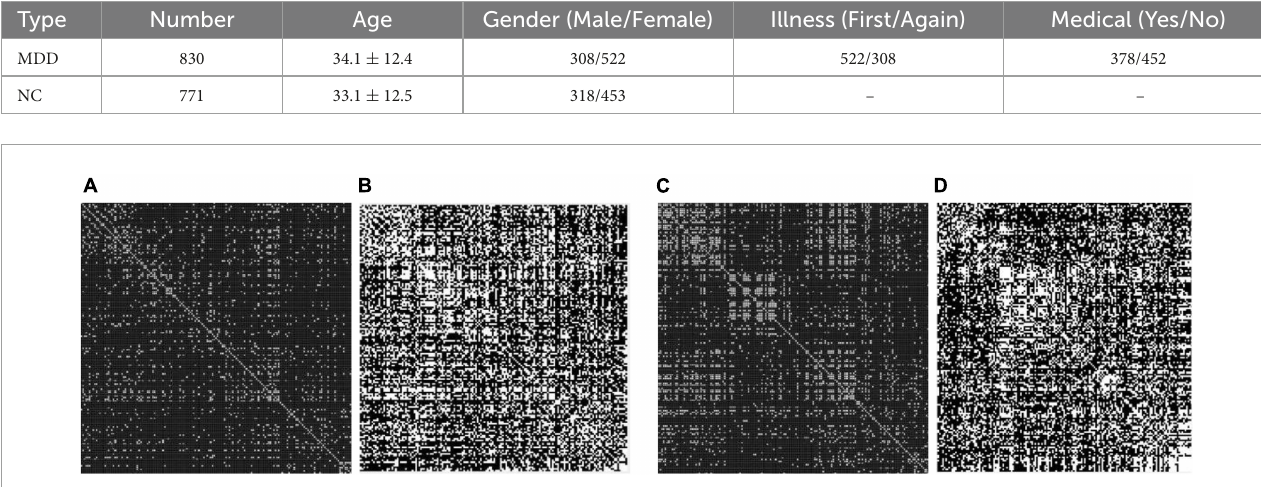
FIGURE1 Adjacency matrix with a different threshold on major depressive disorders (MDDs) and normal controls (NCs). (A) Threshold = 0.4 MDD adjacency matrix; (B) threshold = 0.2 MDD adjacency matrix; (C) threshold = 0.4 NC adjacency matrix; (D) threshold = 0.2 NC adjacency matrix. The black area indicates no interconnected edges between the two functional brain networks, while the white area indicates connected